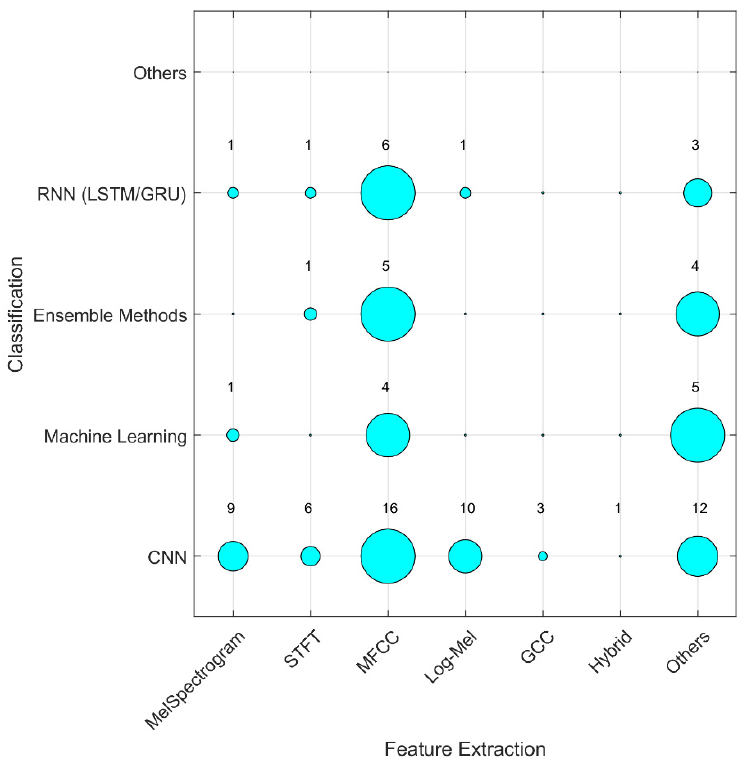
Figure 14. Bubble plot of publications by feature extraction and classification methods. The size of a bubble is proportional to the number of published publications (given above the bubble) and bubble coordinates correspond to the feature extraction and classification methods used.